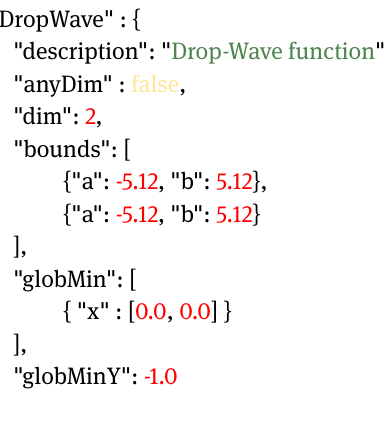
Figure 3: DropWave function.